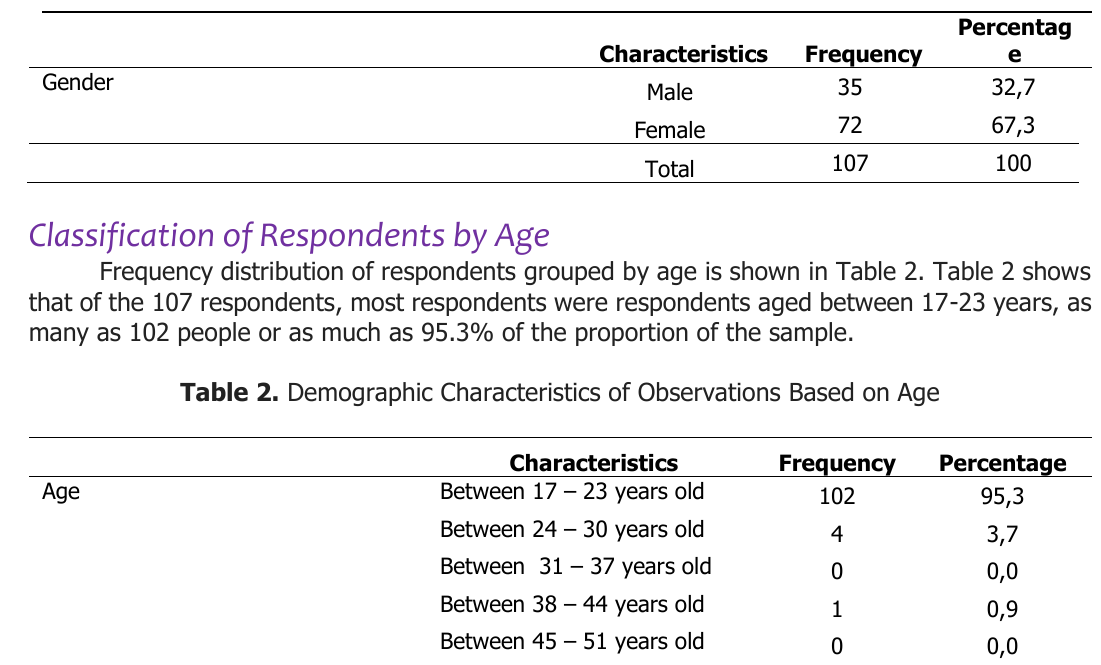
Table 1. Demographic Characteristics of Observations Based on Gender